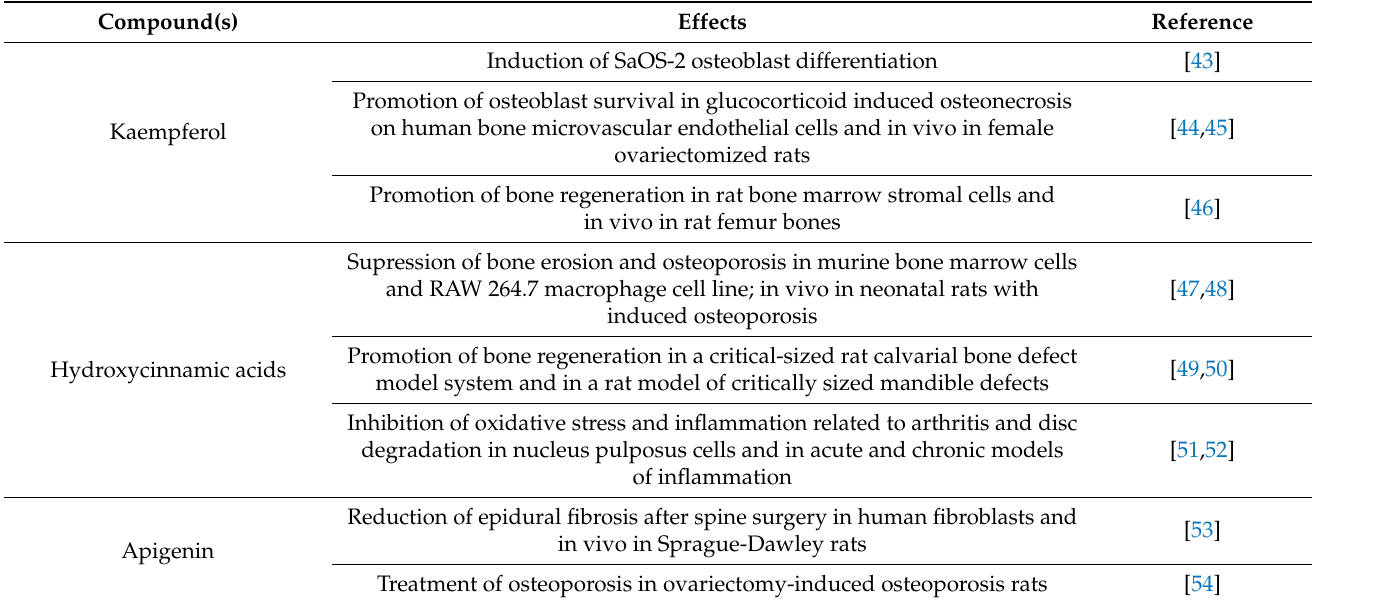
Table 1. Summary of main laurel leaf polyphenols’ effects on